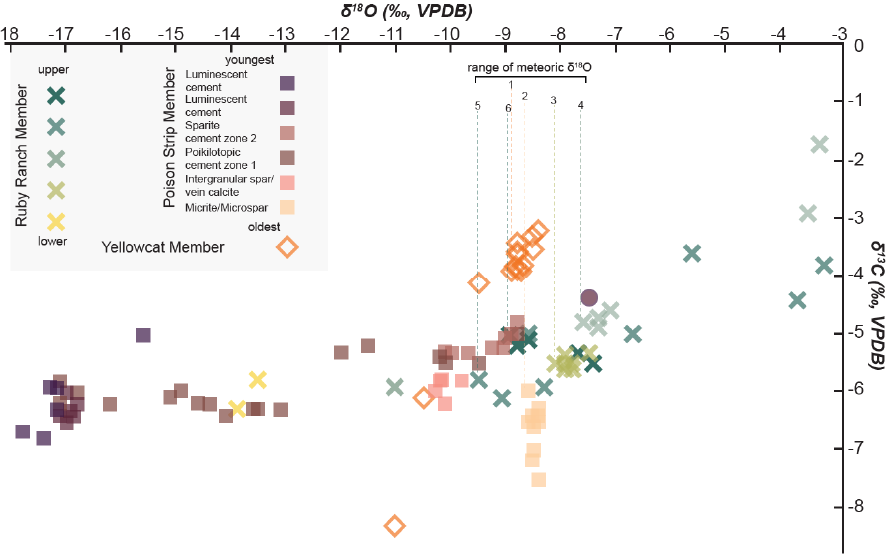
Figure 3. Summary of stable isotope data on carbonate materials in the Cedar Mountain Formation. Data are presented in stratigraphic order as well as inferred temporal sequence (e.g., cement stratigraphy of the Poison Strip member [40]). The Yellow Cat member data are from lacustrine oncoid material [37]. The overlying carbonate-cements sandstones of the Poison Strip member are from [40]. The overlying Ruby Ranch member pedogenic carbonate results are from [22]. Inferred meteoric calcite lines (MCLs) are shown for each of the data sets and numbered sequentially through time, with 1 being the oldest, and 6 being the youngest.